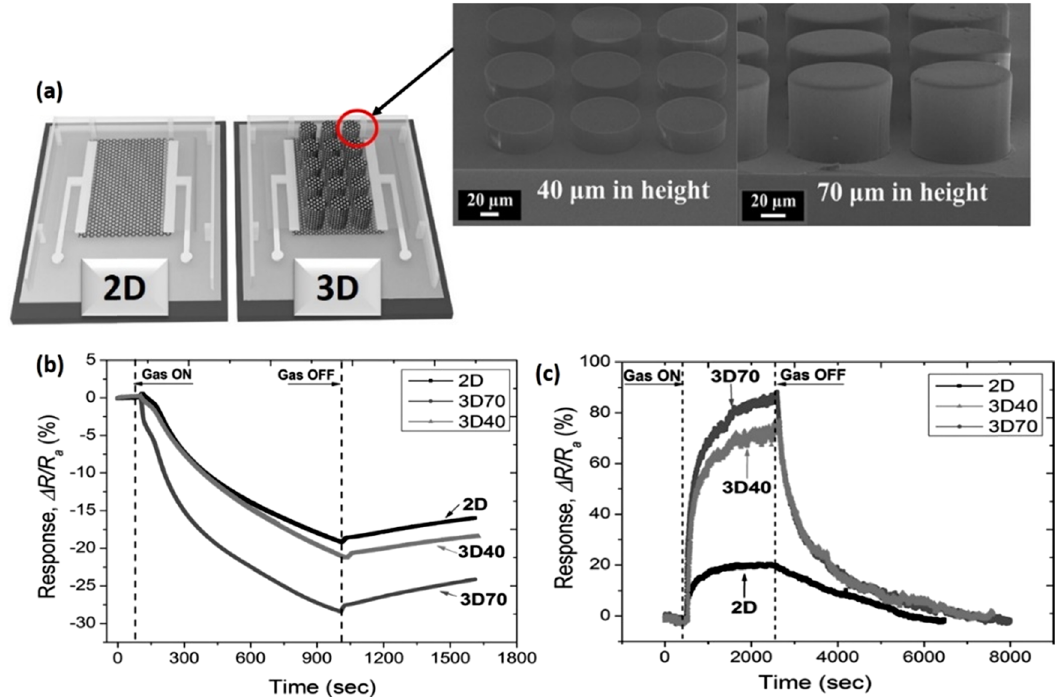
Figure 16: ( a ) Schematic diagram of structure for 2D and 3D devices of SU8 micro ‐ pillar arrays with di ff erent heights of 40 and 70 μ m for 3D devices, ( b ) sensing response of rGO sensors towards a ) 5 ppm NO 2 ( exposure time about 15 min ) and ( c ) 40 ppm NH 3 ( exposure time about 30 min ) . Adapted from ref. [ 123 ]